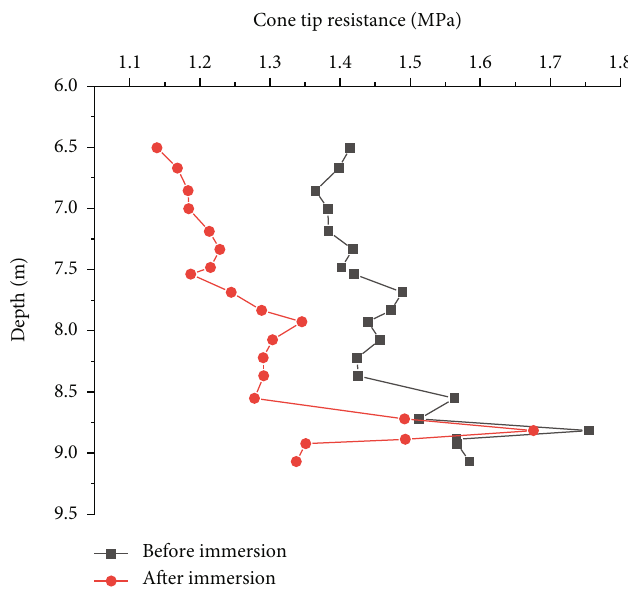
− h curve before and after immersion in the initial section of pipe gallery foundation. Figure 5: Static cone penetration q c